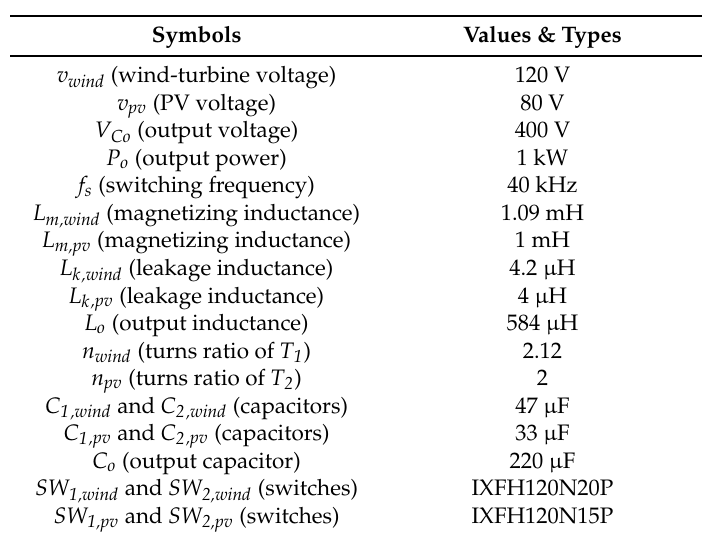
Table 2. The specifications of the